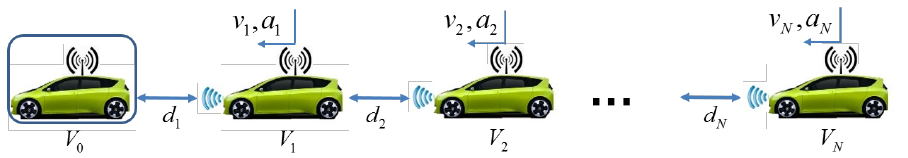
Figure 1. Schematic diagram of a vehicle